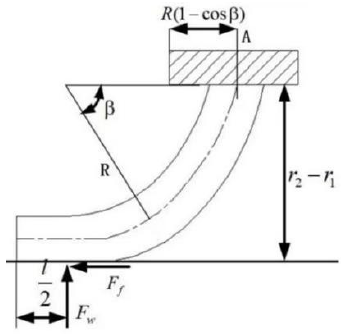
Figure 2. Force diagram of the leather Figure 2 . Force diagram of the leather bowl. Figure 2 . Force diagram of the leather bowl.